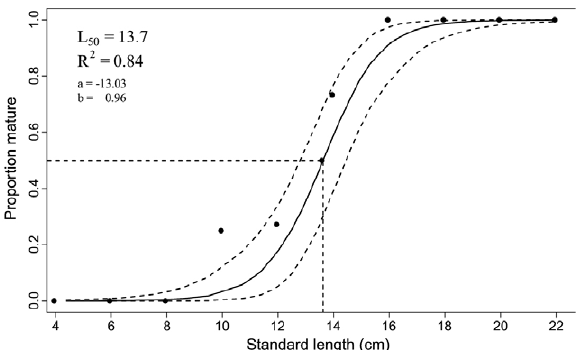
Fig. 2. – Standard length at first maturity (L , cm) and confidence 50 intervals (CI, 95%) for pooled sexes of spotted goatfish, P. macula- tus , captured along the northeast Brazil